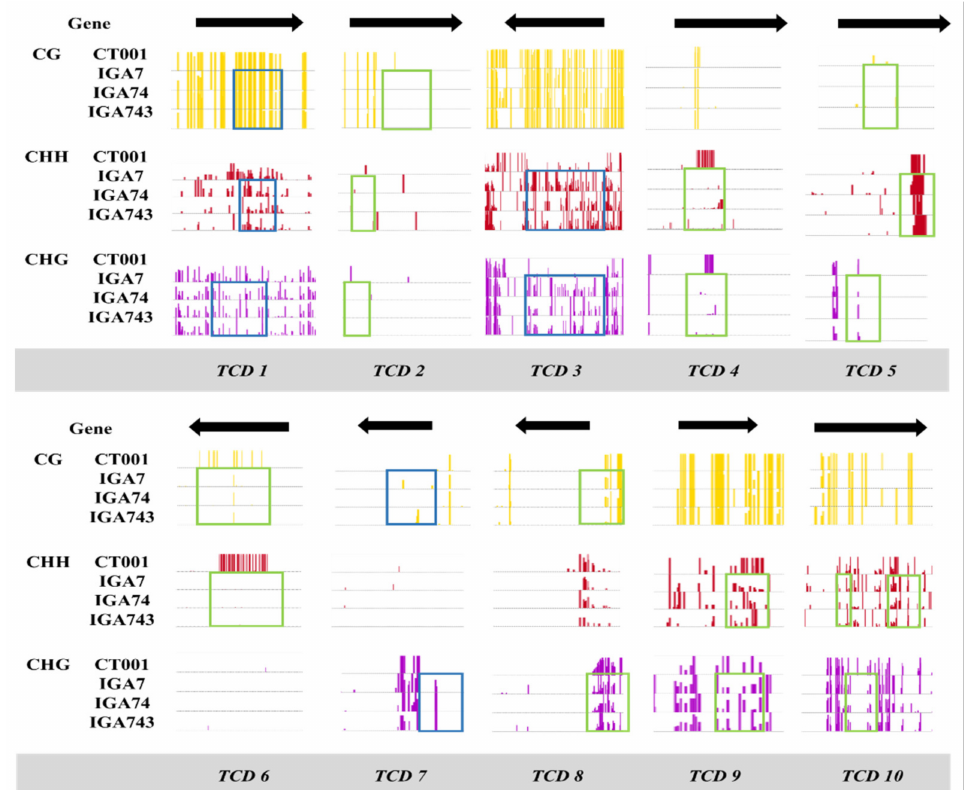
Figure 2. In silico methylation pattern analysis of the transformant-conserved DMRs (TCDs) between the non-transgenic control line ‘CT001’ and transgenic lines (T 1 , T 2 , and T 3 ). Black arrows indicate directions of the genes. The green boxes indicate hypomethylated DMRs, and the blue boxes indicate hypermethylated DMRs in the transgenic